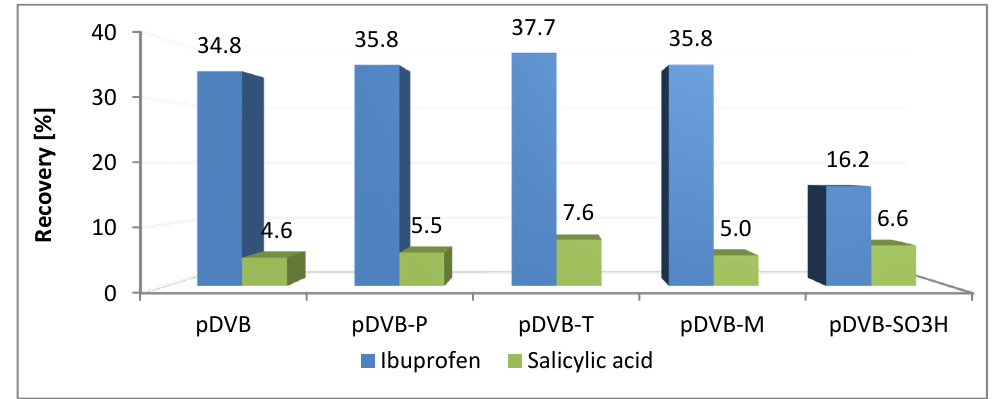
Figure 6. Results of SPE experiments received for the pharmaceuticals.